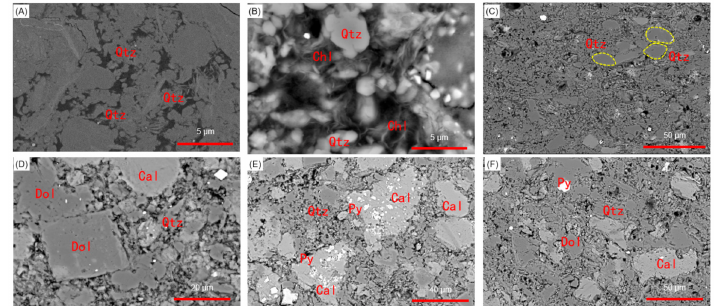
Figure 5. Backscattered electron images showing minerals and grain size of clayey and silty laminae. ( A – C ) clayey laminae, consisting mainly of claystone, are dominantly composed of quartz (70~90%), OM (15~25%), clay minerals (6~15%), and other minerals. For the clayey laminae, quartz is domi- nantly clay-sized with grain size less than 8 ϕ ; ( D – F ) Silty laminae, consisting mainly of siltstone, are dominantly composed of carbonate minerals, quartz, pyrite, and OM. For the silty laminae, quartz is dominantly silt-sized with grain size in the range 4 ϕ to 8 ϕ . Qtz: quartz; Cal: calcite; Dol: dolomite; Chl: chlorite; Py: pyrite. Sample number is 8-2-1.